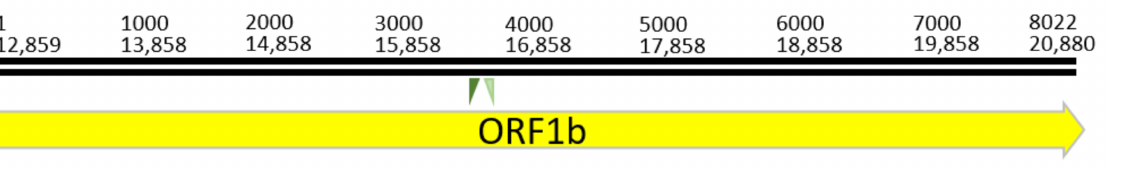
Figure 1. Location of the newly designed batCoV real-time RT-PCR assay (green labels) on the ORF1b gene (yellow), producing an amplicon of 121 bp at nucleotide position 16,286–16,406. RNAs of all rectal swab and feces pellets, collected at the three sampling points, were tested with the newly designed bat α -CoV real-time RT-PCR assay to determine the prevalence of the new strain in the samples